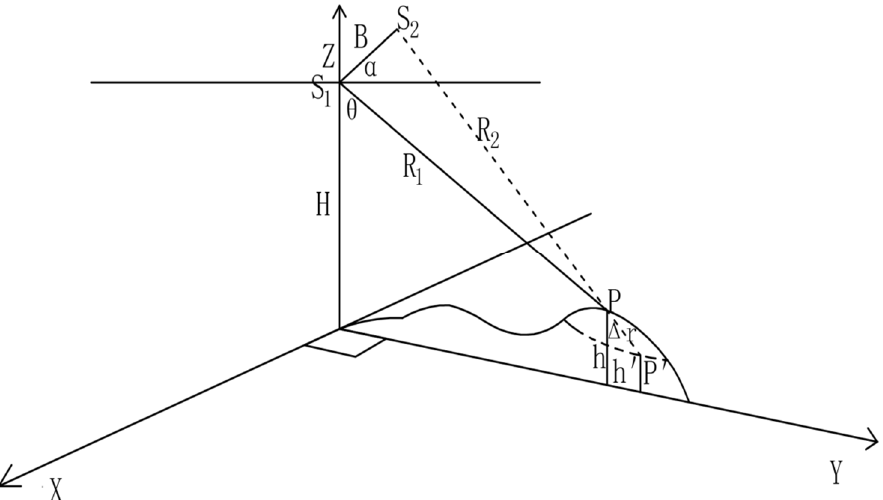
Figure 3. DInSAR principle and geometric relationship of surface deformation.